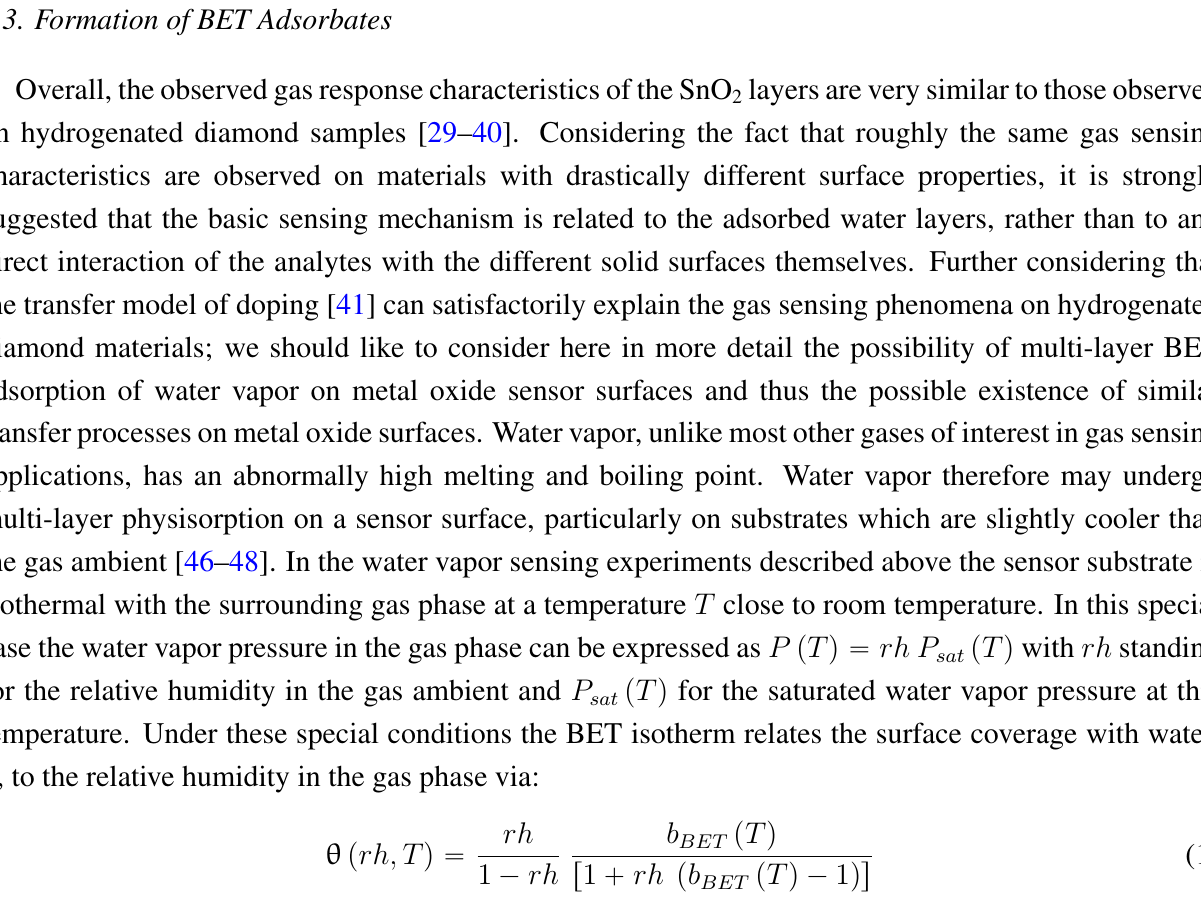
Figure 5. Gas response of SnO layers with a flat and a nano-granular surface morphology 2 towards non-acid and non-base forming gases. The response to the acid former NO for comparison at the end of each exposure sequence; background dry synthetic air ( a ) and humidified synthetic air background, rh = 30% ( b